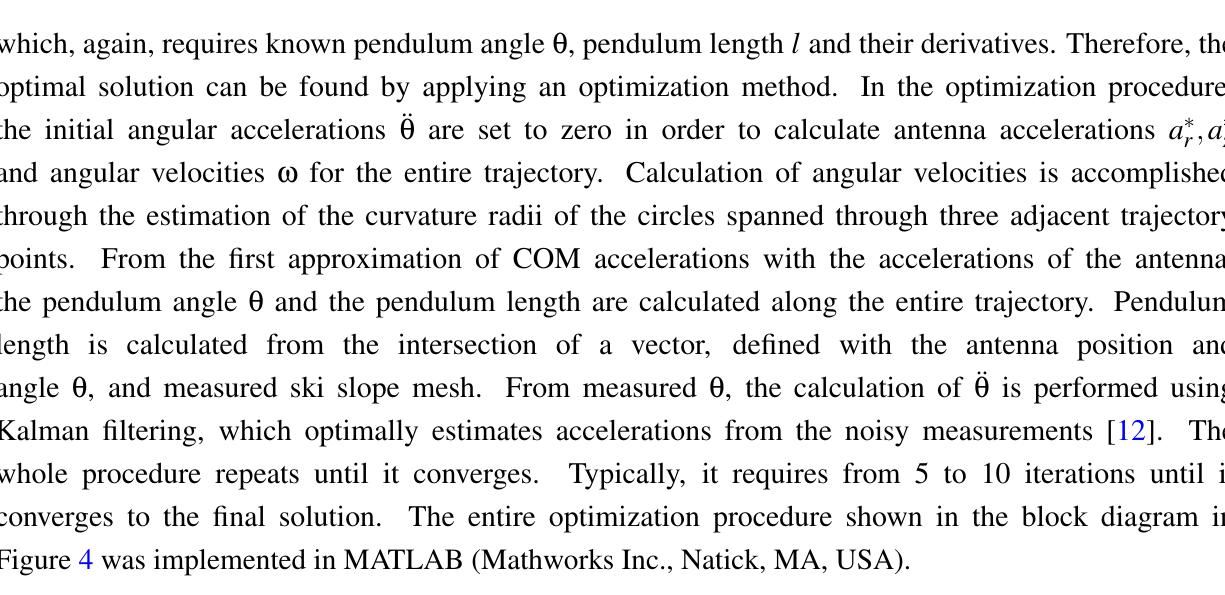
Figure 4. Block diagram of optimization procedure for estimating skier’s posture using the inverted pendulum